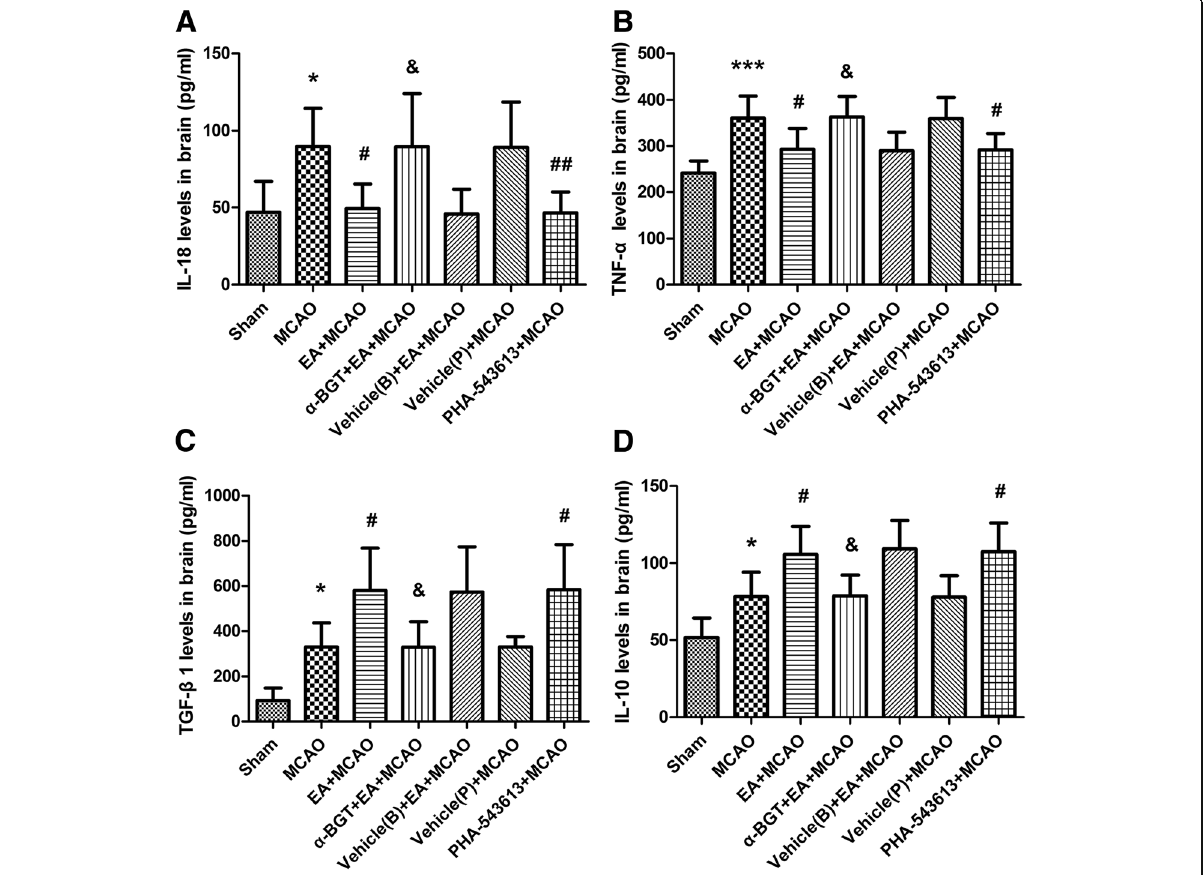
Fig. 6 EA stimulus regulates the balance between proinflammatory factors and anti-inflammatory cytokines through α 7nAChR. Representative ELISA analysis of proinflammatory factors IL-18 ( a ), TNF- α ( b ) and anti-inflammatory cytokines TGF- β 1 ( c ), IL-10 ( d ) ( n =8 for each group). Compared with sham group, cerebral I/R injury up-regulated the levels of IL-18, TNF- α and TGF- β 1, IL-10. EA stimulus down-regulated the levels of proinflammatory factors (IL-18, TNF- α ) and up-regulated the contents of anti-inflammatory cytokines (TGF- β 1, IL-10) as compared to MCAO group. Intraperitoneal injection of PHA-543,613 exerted similar beneficial effects as that of EA stimulus. Meanwhile, the administration of α 7nAChR antagonist α -BGT reversed the effects of EA stimulus. * P <0.05, *** P <0.001 vs. Sham group, # P <0.05, ## P <0.01 vs. MCAO group, & P <0.05 vs. EA+MCAO